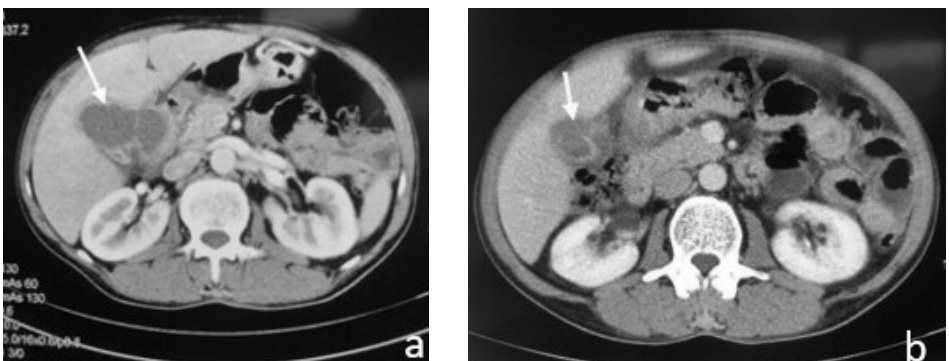
Figure 6. Contrast-enhanced CT shows: ( a ) gallbladder associated with pericholecystic fat stranding, gallbladder wall thickening, and liver abscess (white arrow); ( b ) gallbladder with wall thickening and a so-called “ring sign”, without central enhancement (white arrow).